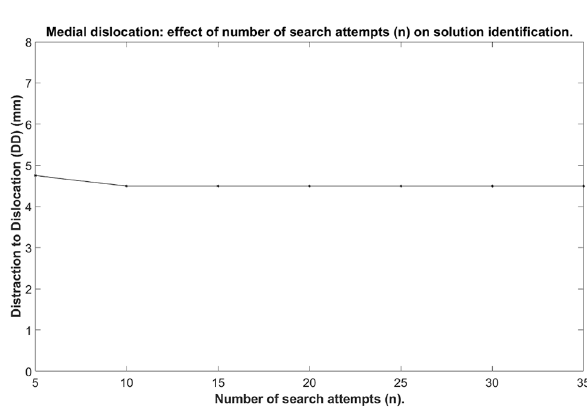
Figure 5. Mechanical rig used to study mobile bearing dislocation.